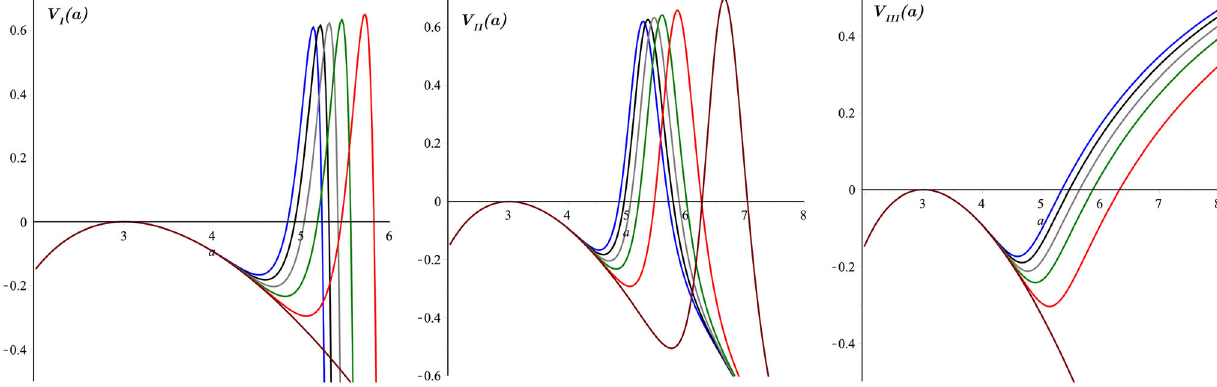
to 0 . 0000 (the rightmost curve) with steps equal to 0 . 0002 . Hence, = 16 , − 16 = 0 . 0000 , 0 . 0002 , 0 . 0004 , 0 . 0006 , 0 . 0008 and 0 . 0010 correspond v 0 0 to the brown, red, green, gray, black and blue curve respectively